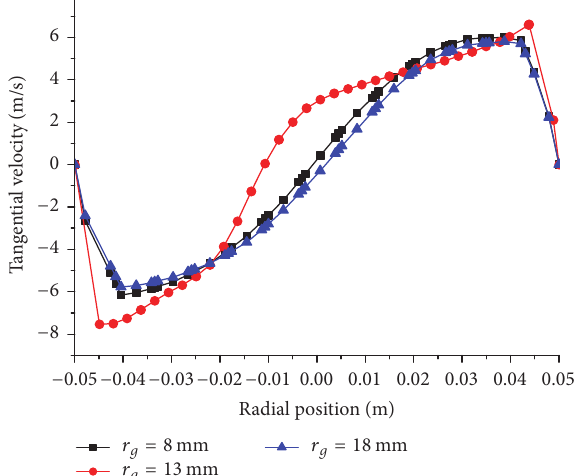
Figure 9: Tangential velocity distribution on the cross section of the separator middle position.